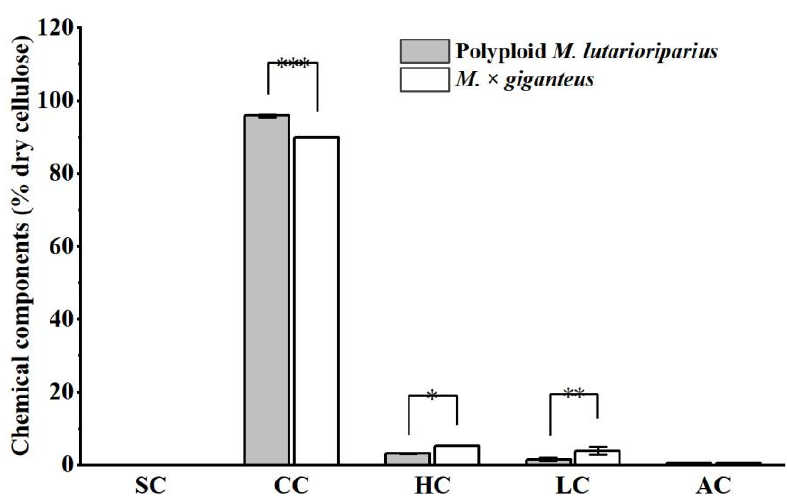
Figure 4. Chemical components of crude cellulose in polyploid Miscanthus lutarioriparius and Miscanthus × giganteus . * Significant difference at p ≤ 0.05, ** Significant difference at p ≤ 0.01, *** Significant difference at p ≤ 0.001. Vertical bar are standard deviation ( n = 2).